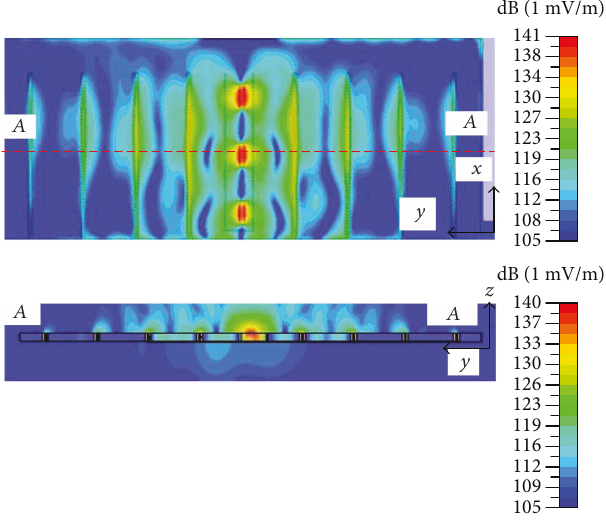
Figure 4: Field distributions from top view and its cross-sectional view along line AA 1